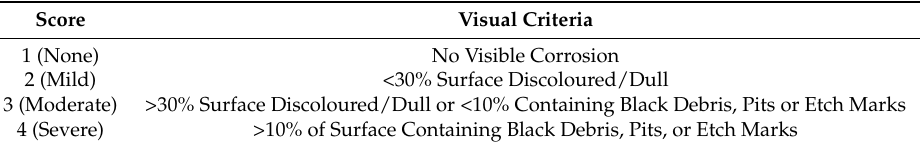
Table 2. Visual criteria for scoring corrion damage.